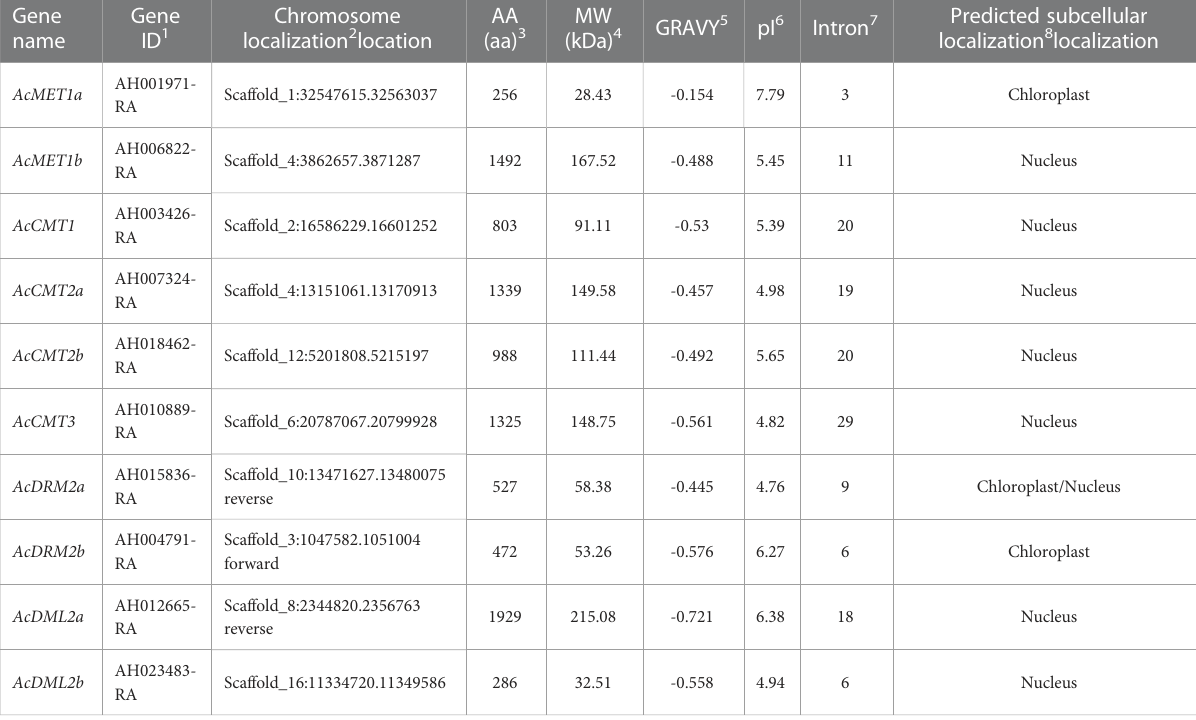
TABLE 2 Characterization of A. cruentus C5-MTase and DMTase genes; 1 Gene ID from A.hypochondriacus genome in Phytozome database; 2 Chromosome location in the genome of A.hypochondriacus ; 3 AA – number of amino acids; 4 MW – protein molecular weight; 5 GRAVY –